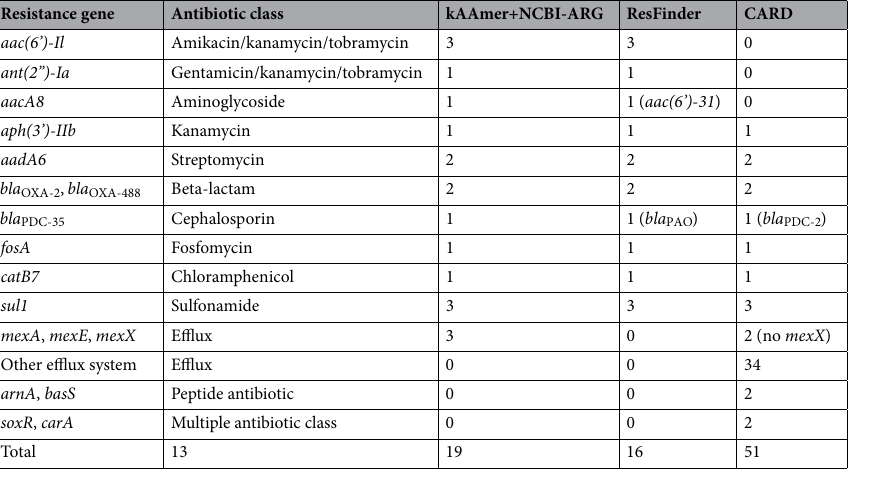
Table 1. Report of the antibiotic resistance gene identification in the pan-resistant Pseudomonas aeruginosa E6130952 strain from kAAmer+NCBI-arg, ResFinder and CARD